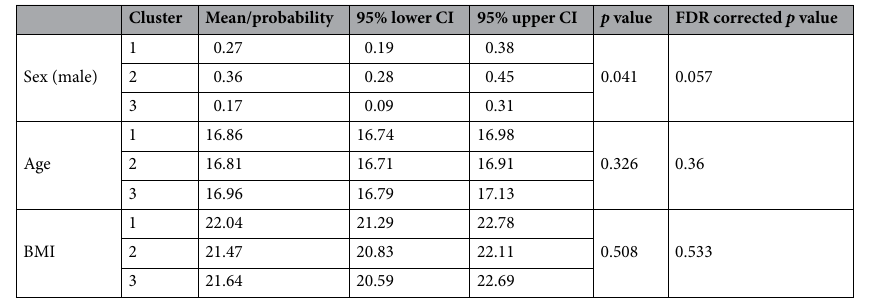
Table 1. Associations between clusters and demographic characteristics. Estimates are presented either as probabilities (sex), or as group averages (age and BMI). Confidence intervals are calculated using bias corrected bootstrapping with 1000 bootstrapped resamples. False discovery rate corrected p values take account all omnibus analysis presented in article. BMI body mass index (weight per square height, kg/m 2 ), CI confidence interval, FDR false discovery